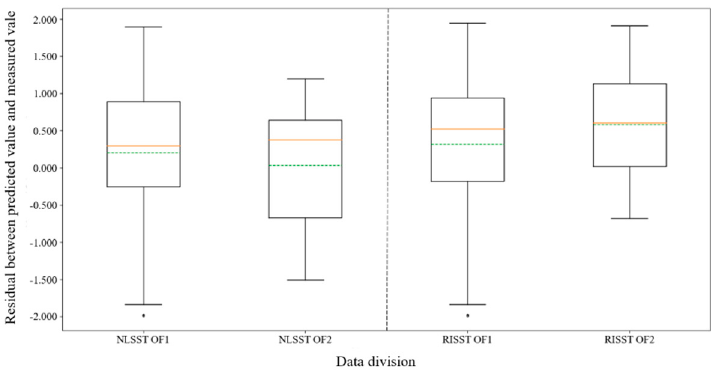
Figure 4. Residual boxplot of the eNLSST and RISST algorithms with group OF1 and OF2.